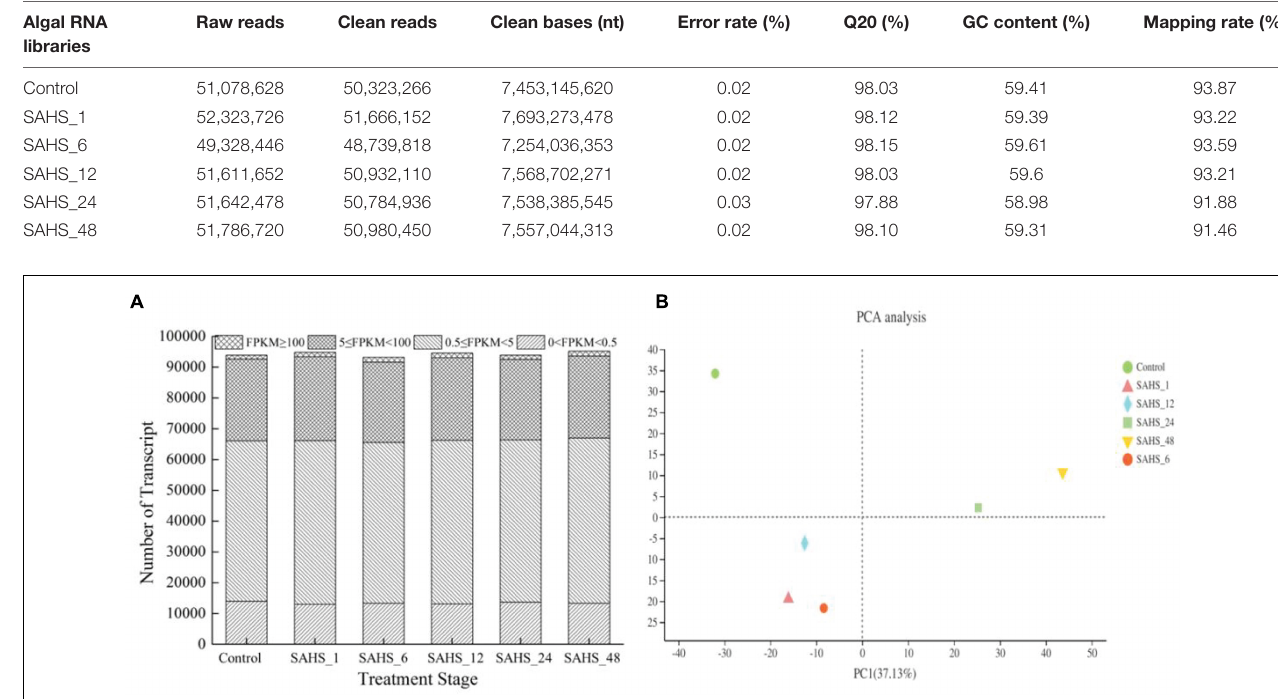
TABLE 2 | RNA sequencing and mapping results.